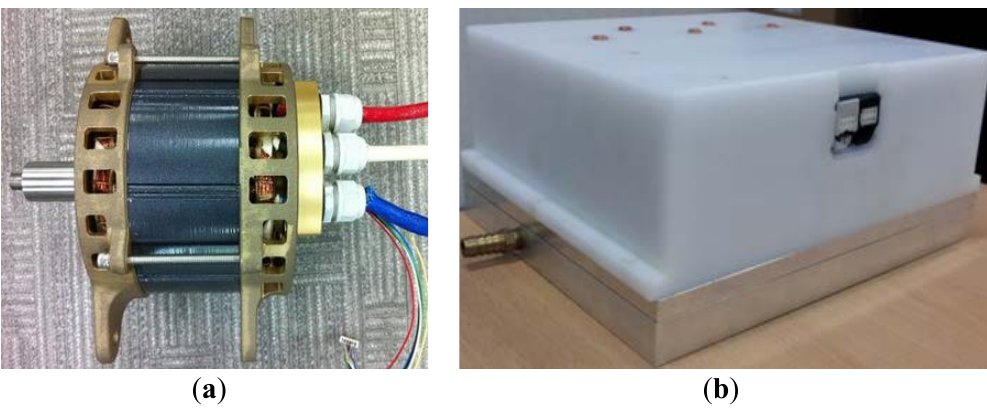
Prototypes of ISG motor and inverter: ( a ) air-cooled motor; and